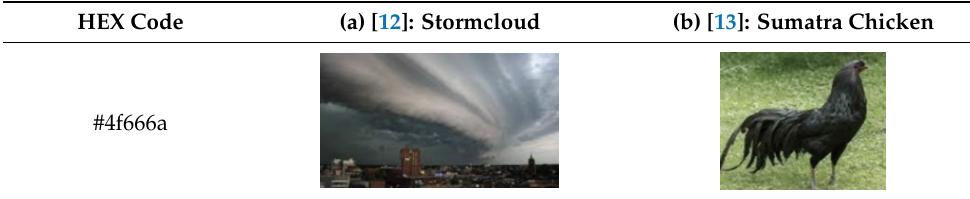
Figure 3. A variety of different beer colors and tea colors.